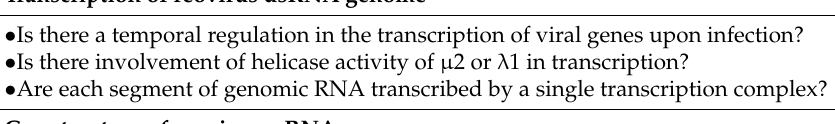
Table 1. Remaining questions on synthesis and translation of reovirus mRNA Transcription of reovirus dsRNA